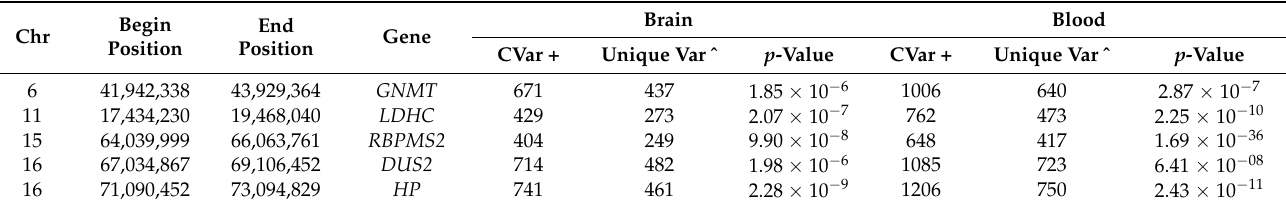
Table 2. Significant gene-level eQTLs common to blood and